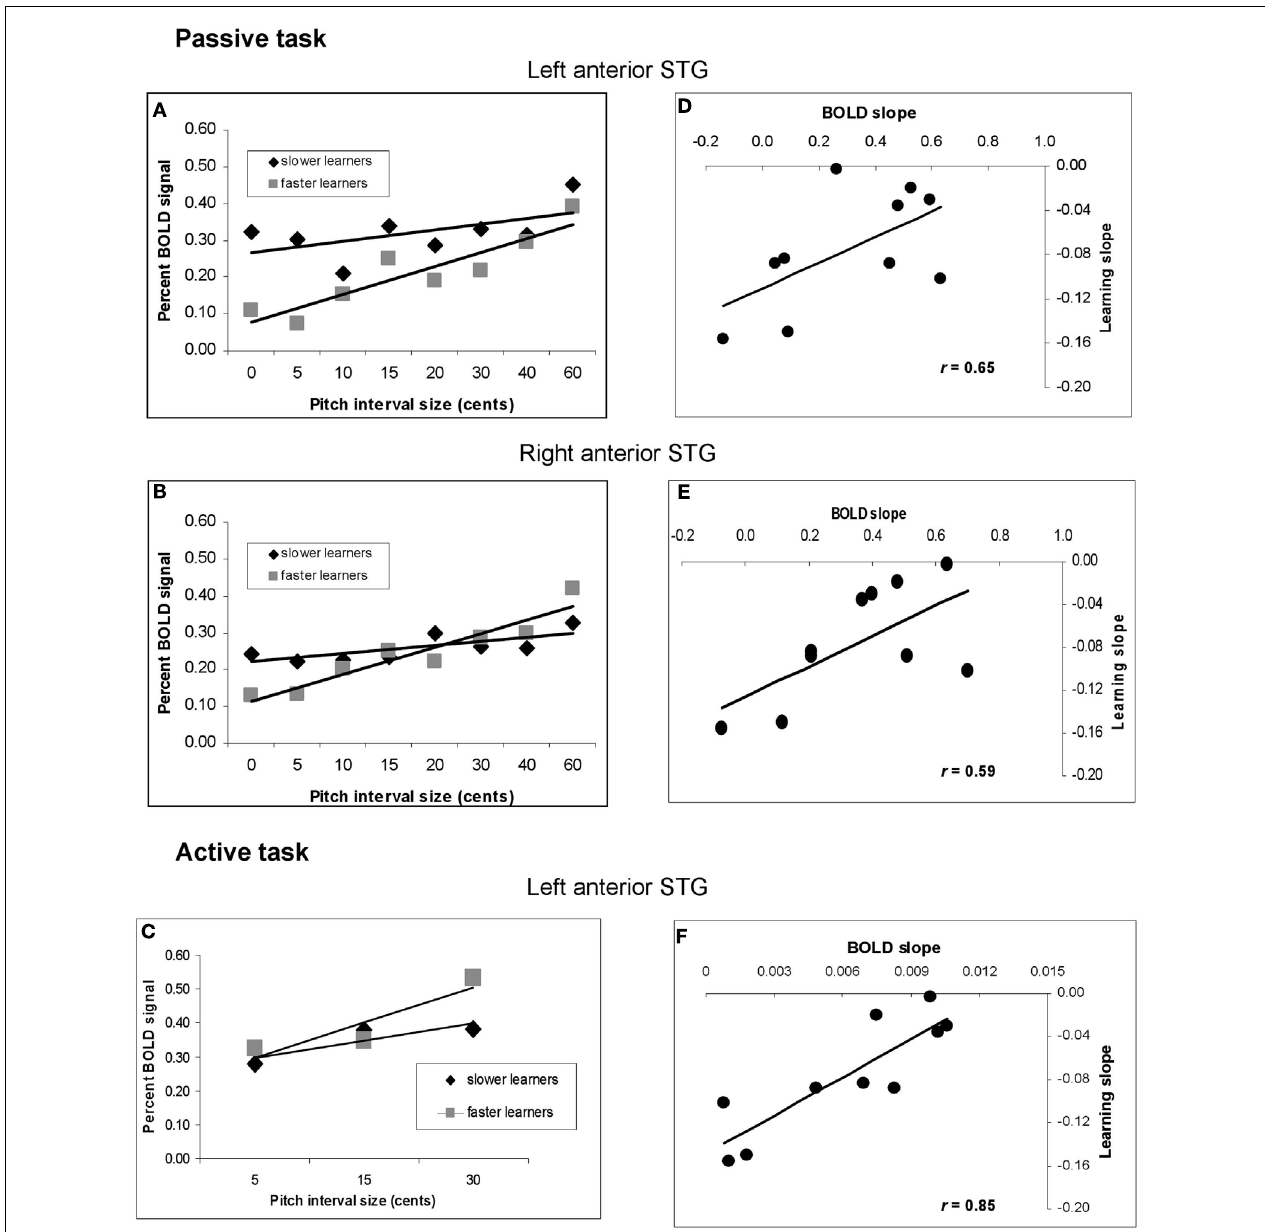
between slope of BOLD response to increasing pitch interval size pre-training (abscissa) and behavioral learning slope (ordinate) at the same right anterior STG region as in (A) . Each symbol represents one individual. (E) As in (D) , but for the right anterior STG region corresponding to (B) . (F) As in (D) but for the active task, left anterior STG location corresponding to (C) .The significant correlations in all three cases indicate that the higher the individual BOLD response was to increasing pitch interval size prior to training, the faster the behavioral thresholds dropped to asymptotic levels during